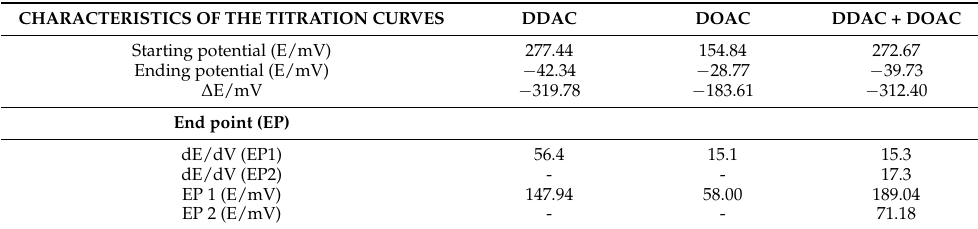
Table 4. Characteristics of the titration curves of model solutions of DDAC, DOAC, and the two- component mixture of BAC and DOAC (1:1 w / w ).